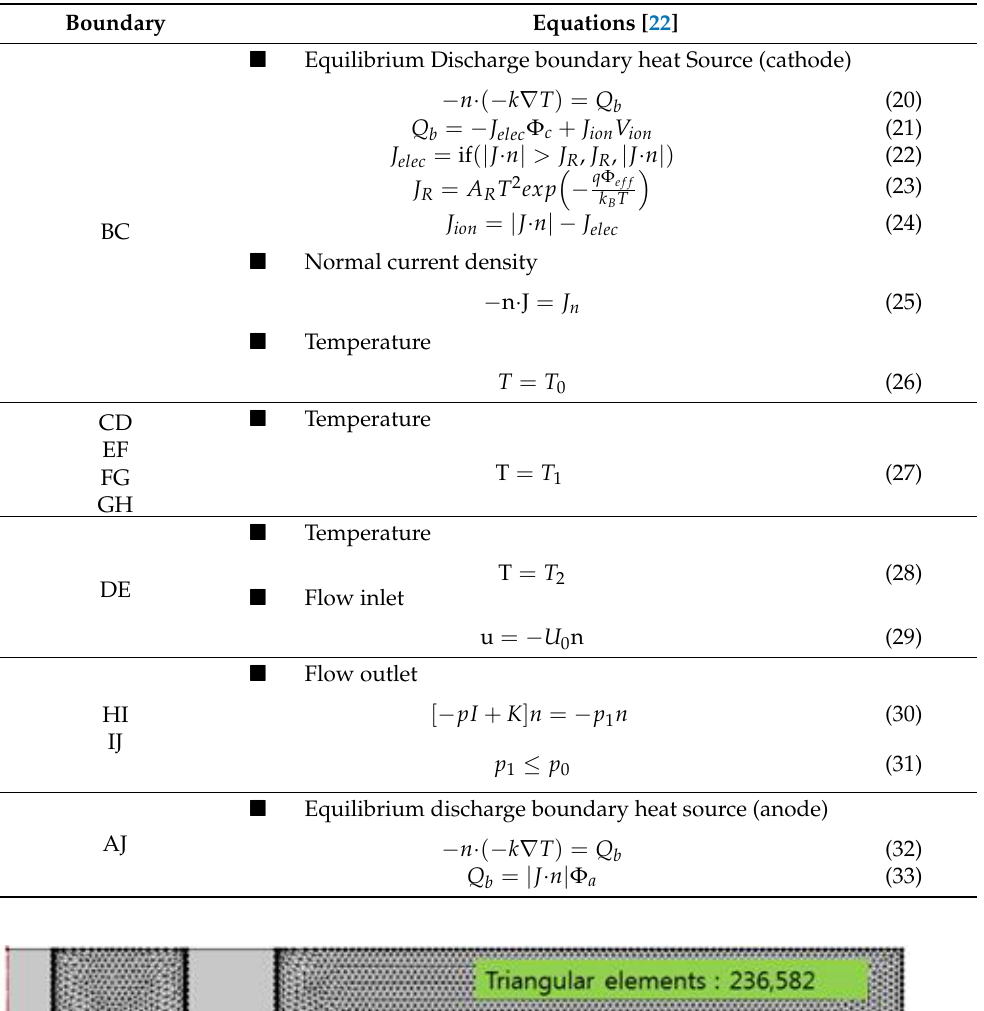
Table 1. Boundary and initial conditions.